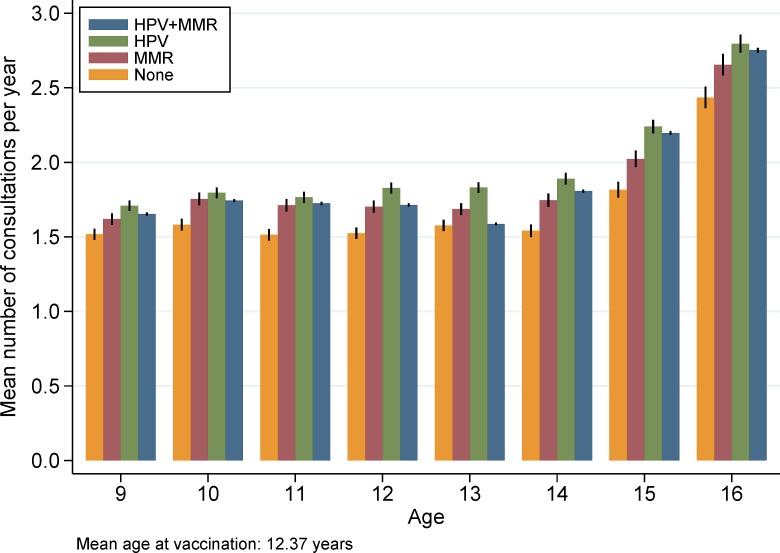
Mean number and 95% CIs of daytime GP face-to-face consultations by age according to vaccination status.